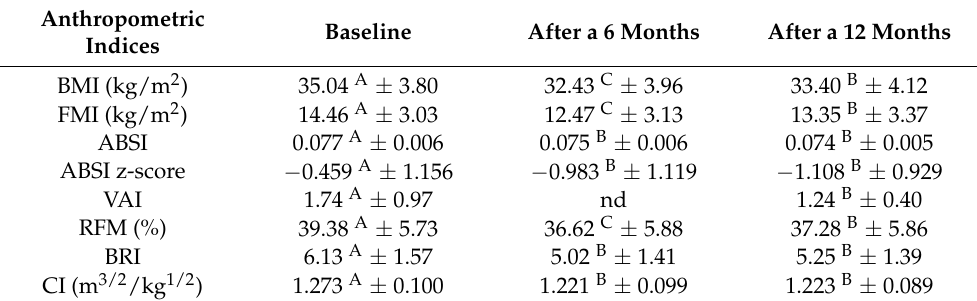
Table 2. Changes in anthropometric indices during the weight loss